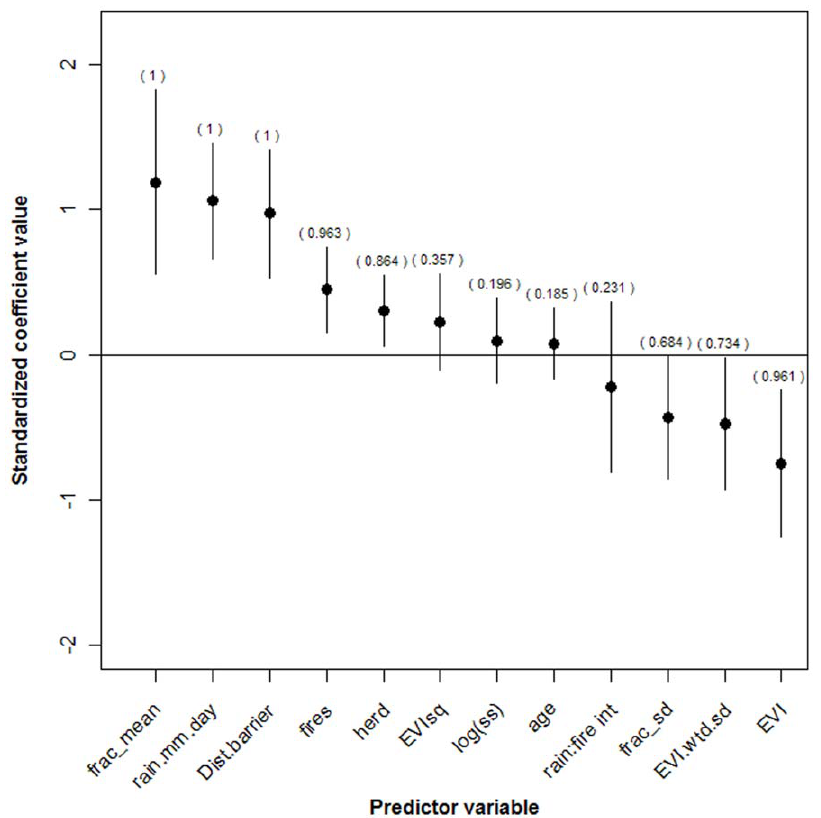
Figure 3. Results of statistical modeling. Model-averaged (over the set of 4096 candidate regression models) standardized regression coefficients for variables explaining wet season migratory movements in African buffalo. Variable abbreviations: frac_mean=Proportion of home range in woodlands; rain.mm.day=Average rainfall on dry season home range (mm); Dist.barrier.avg=Distance to nearest linear barrier (river, fence, or cultivated area), metres; EVIsq=Square of EVI variable; age=Animal’s age at capture (years); fires=Binary variable indicating presence of fires on dry season home range; log(ss)=Number of wet season GPS observations (log-transformed); herd=Size of animal’s herd at capture; rain:fire int=Interaction variable of rainfall and fire presence; EVI.wtd.sd=Standard deviation of EVI variable; EVI=Average EVI value on dry season home range; frac_sd=Standard deviation of frac_mean variable.